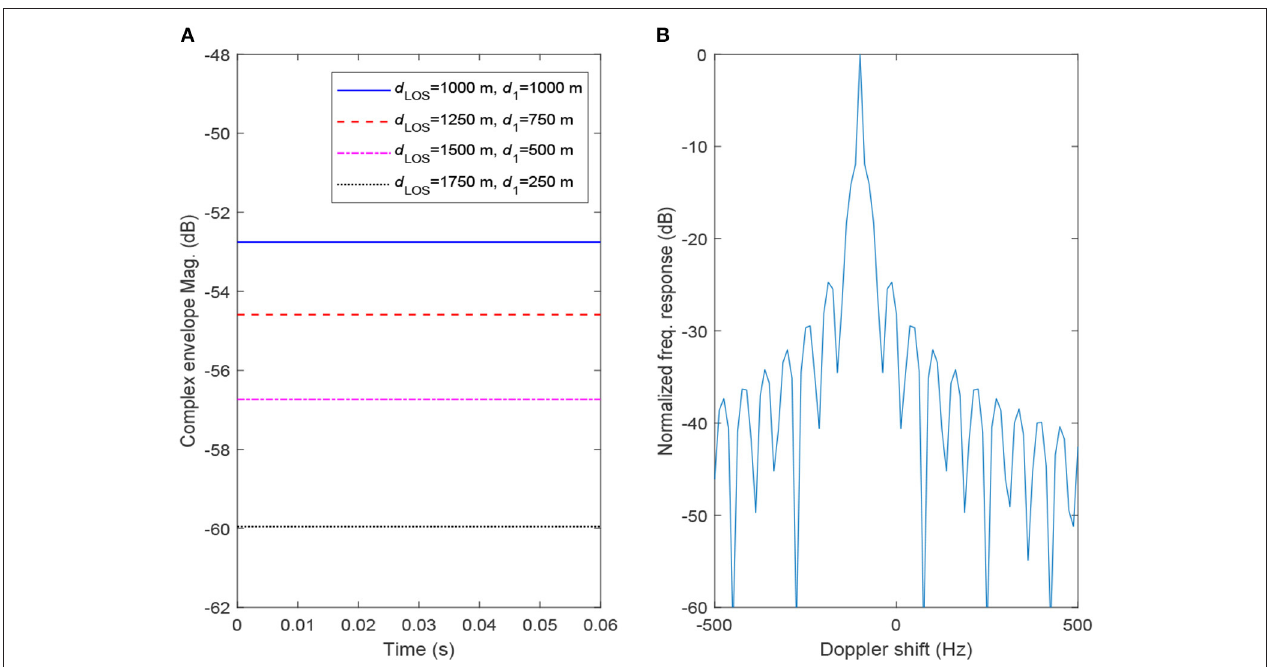
FIGURE 5 | (A) Minimized magnitude of the received signal in the presence of an RIS, (B) Doppler spectrum of the received signal for all scenarios.